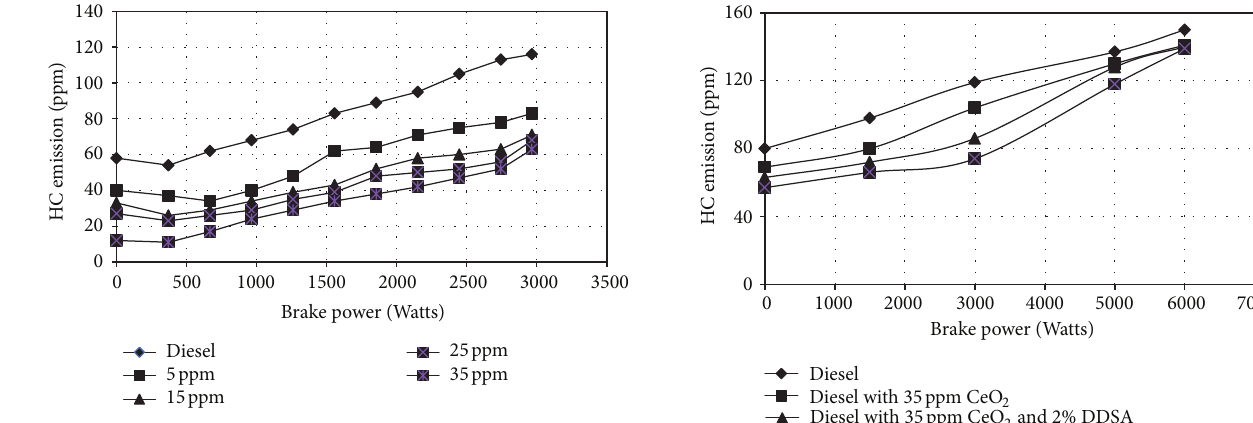
Figure 10: Variation of HC emissions with load for diesel and mod- ified diesel.